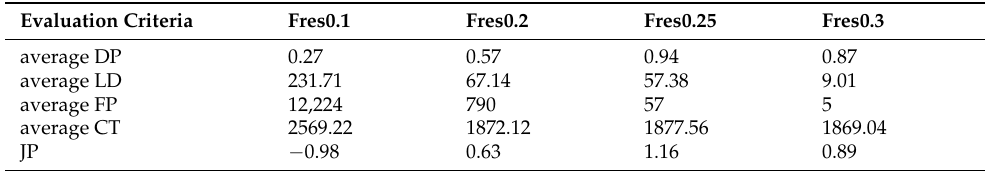
Table 2. The JP and average results of DP , LD ( ‰ ) , FP and CT ( s ) of the proposed method with four different frequency resolutions 0.1, 0.2, 0.25 and 0.3